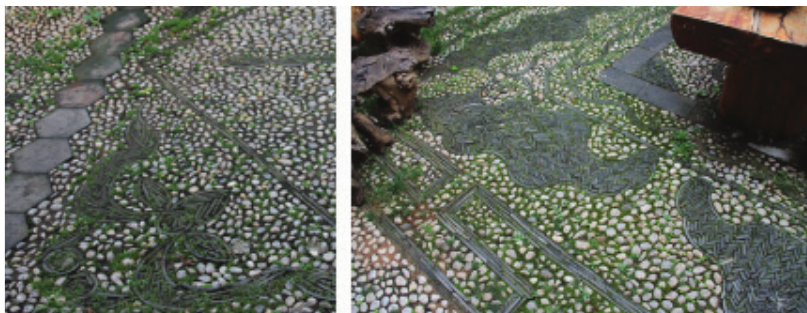
Figure 13. Paving with pebbles, tiles and bricks (photos by the fi rst